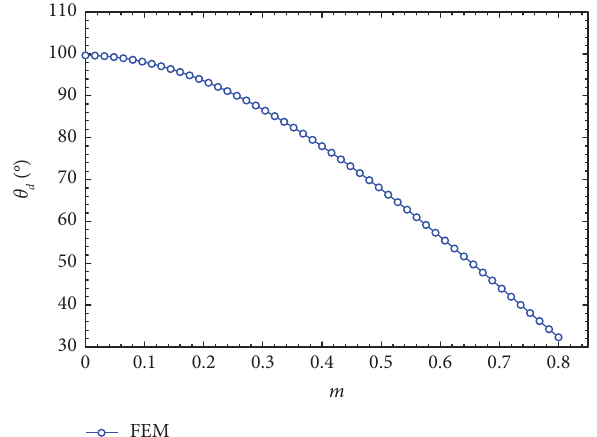
Figure 13: Breakout failure width versus